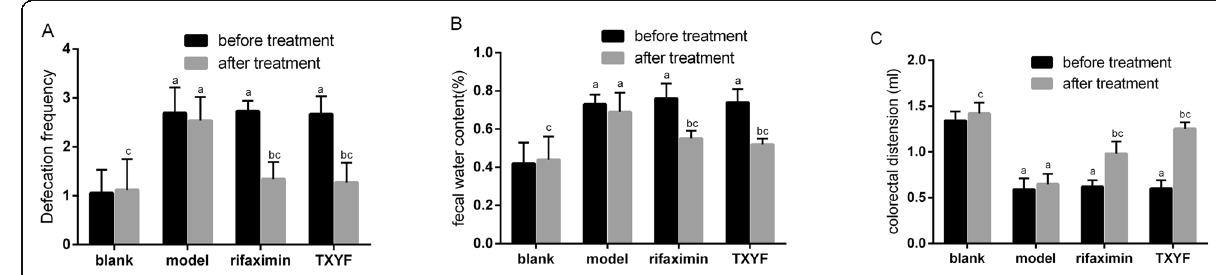
Fig. 1 Effects of TXYF on defecation frequency, FWC and CRD in IBS-D rats. a Defecation frequency, ( b ) faecal water content, and ( c ) colorectal distension. a P < 0.05 vs the blank group. b P < 0.05 vs before treatment. c P < 0.05 vs the model